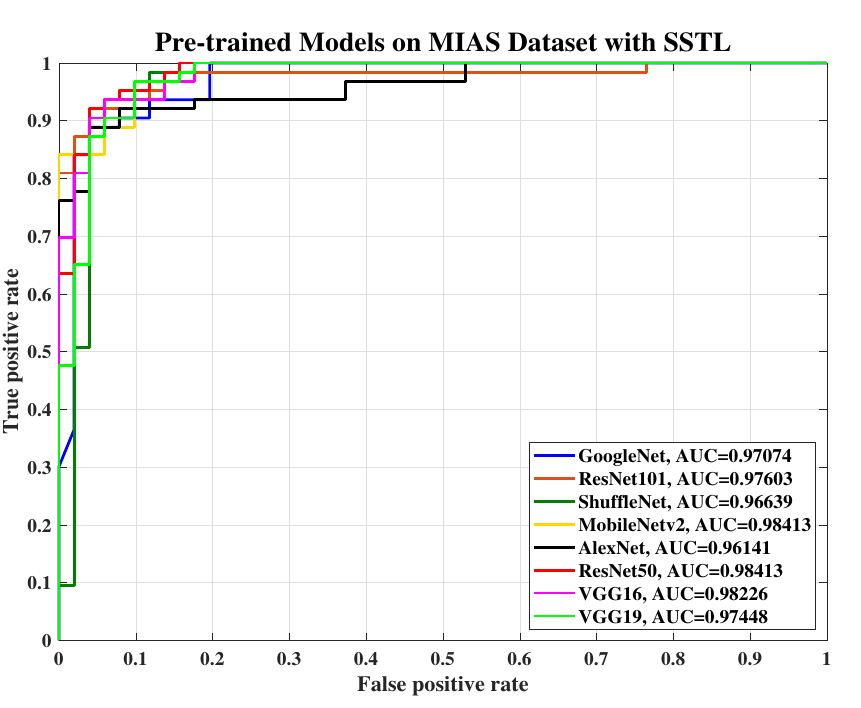
Figure 7. The receiver operating characteristic (ROC) curve of various pre-trained models with SSTL for breast cancer classification using the MIAS